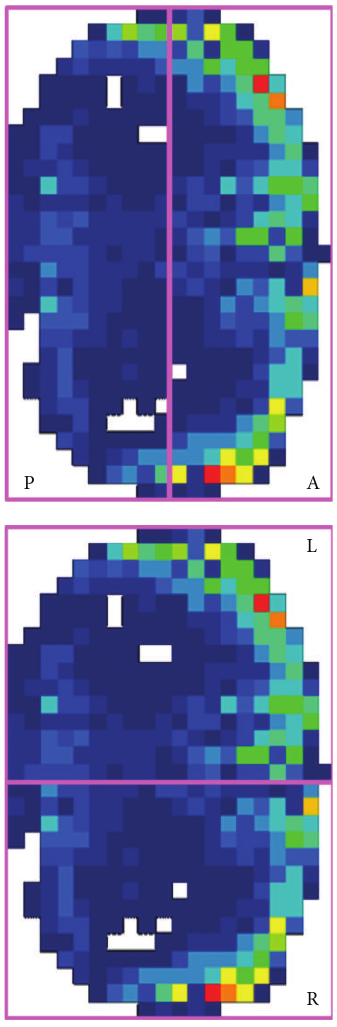
Figure 4: Pressure area division by bounding box: anterior (A), posterior (P), left (L), and right (R).